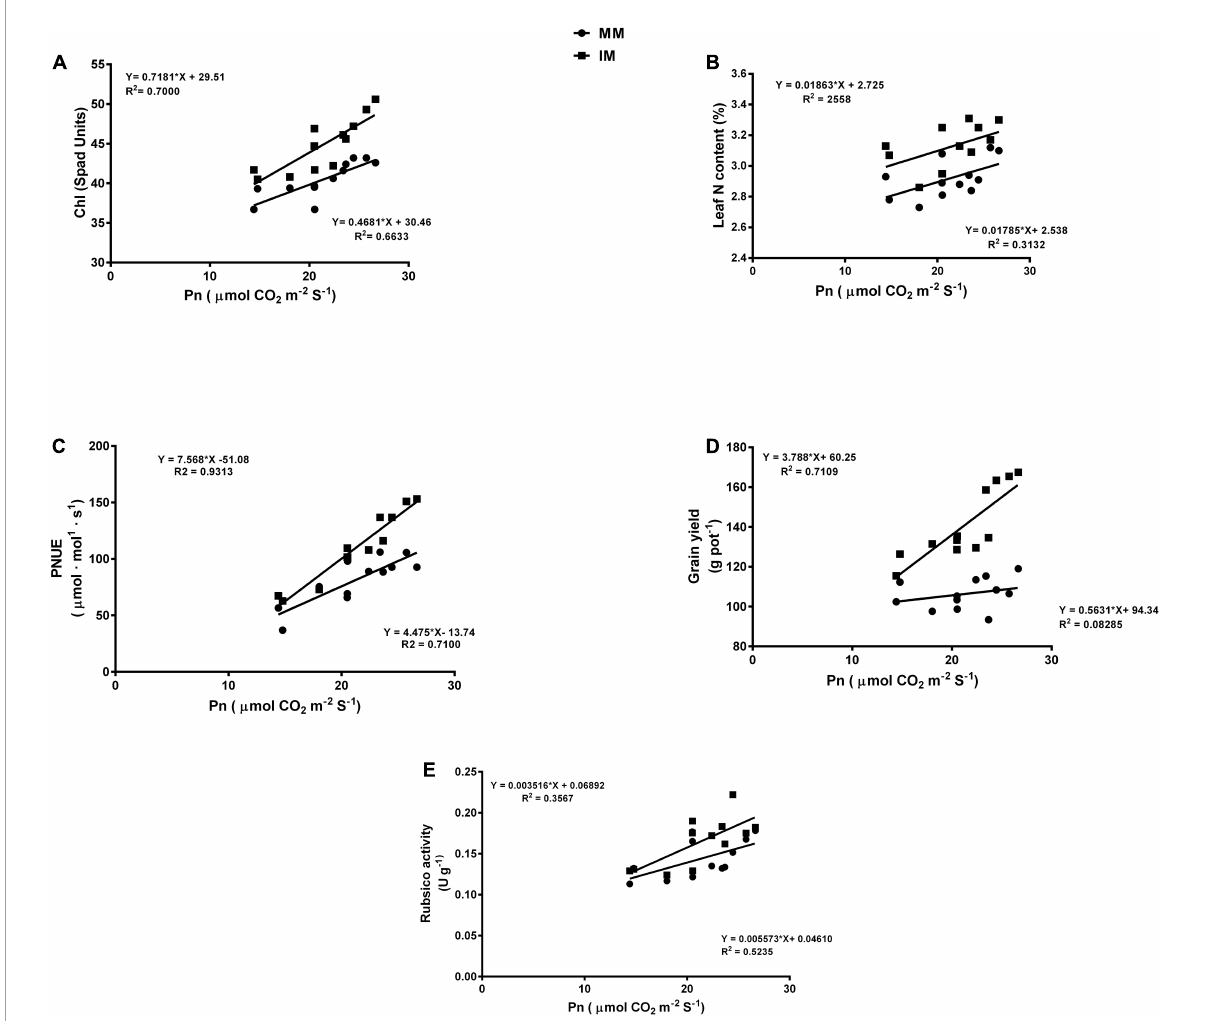
FIGURE6 Regression analysis of the photosynthetic rate with chlorophyll (Chl) (A) , leaf N content (B) , PNUE (C) , grain yield (D) , and biomass yield (E) of the maize crops of maize during mono-cropping and intercropping. MM, maize mono-cropping; IM, maize